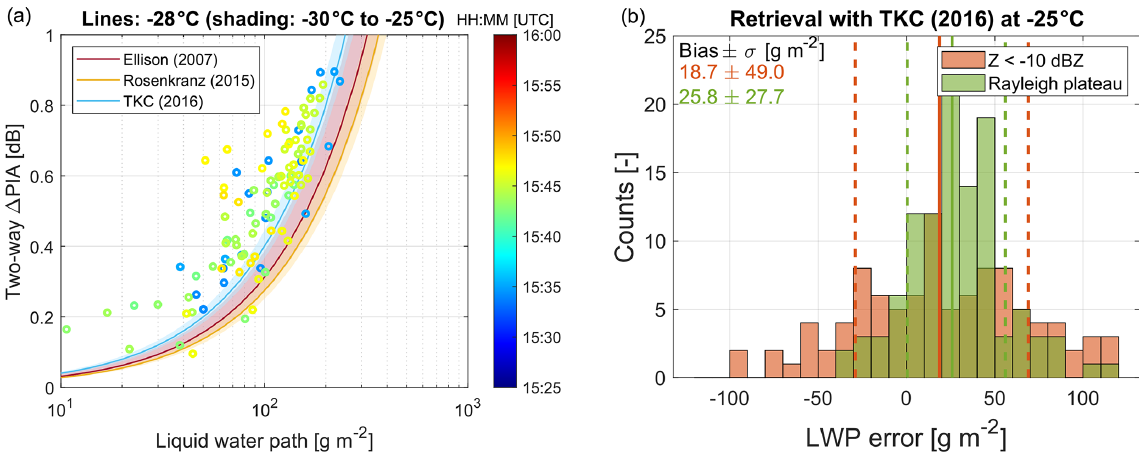
Figure 8. Same as Fig. 6 but for the period between 15:25 and